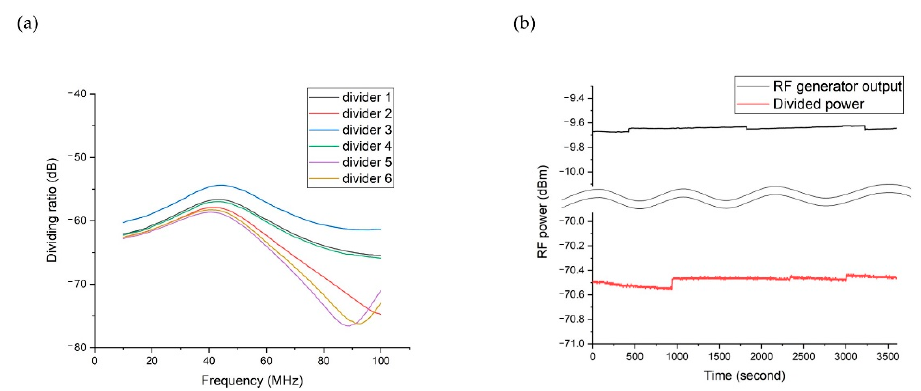
Figure 7. Characterization of voltage divider modules. ( a ) Measured dividing ratios of six voltage dividers as a function of input frequency (input power = − 10 dBm). ( b ) Measured RF power of an RF generator output and output of voltage divider 1 over 1 h (input signal = 22.2 MHz, − 10 dBm). RF generator output and divider power were measured at different times, but they were plotted in the same plot to show the time scale of RF power measurement drift. The standard deviation of the divided power is 0.028